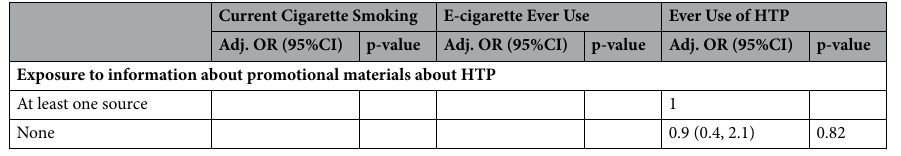
Table 4. Factors associated with current CS, ever use EC and HTP. × retired, unemployed, unable to work